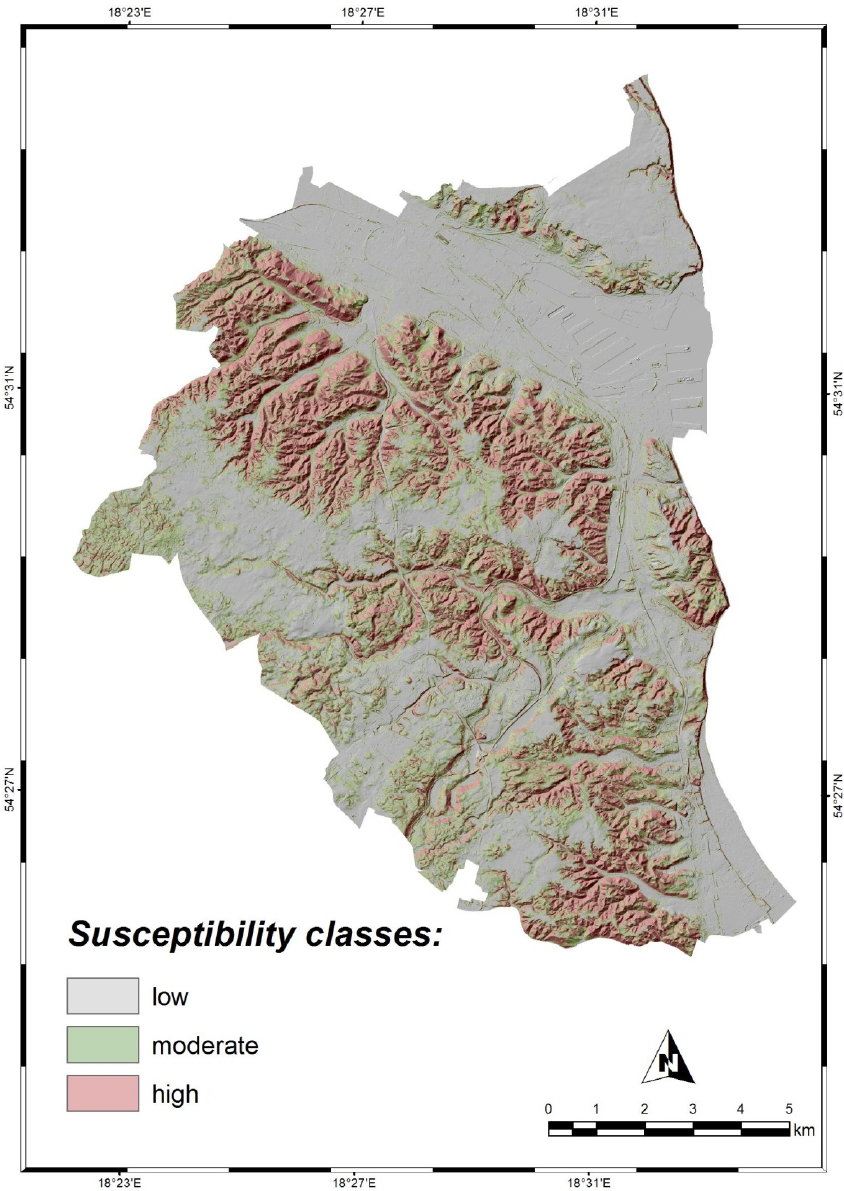
Figure 7. Landslide susceptibility map of Gdynia and Sopot developed using statistical landslide index (SLI). index